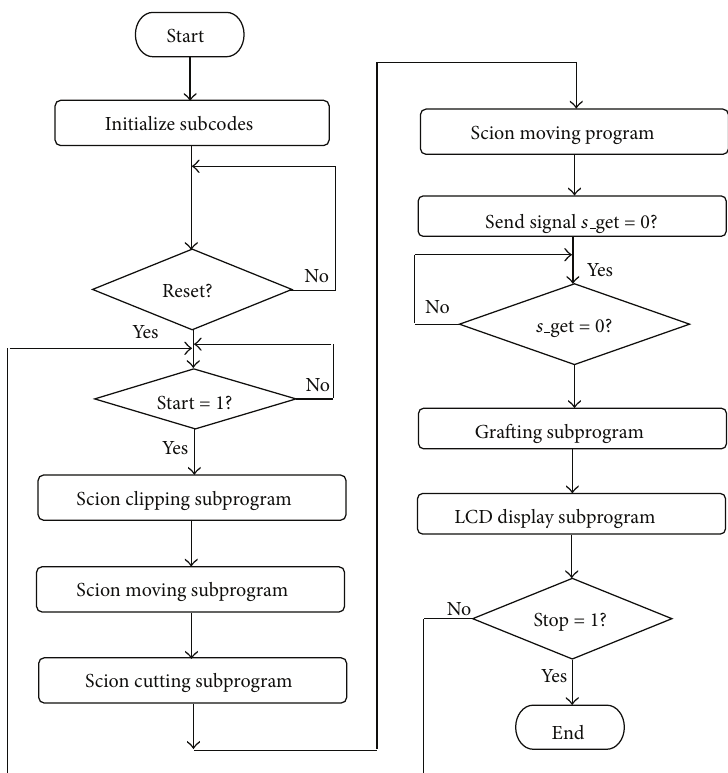
Figure 13: Flow diagram of scion processing main control module.